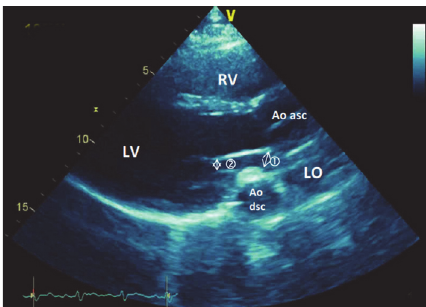
Figure 2: Echocardiography at maximal exercise. RV, right ven- tricle; LV, left ventricle; LO, left atrium; Ao dsc, descending aorta; Ao asc, ascending aorta; A , compression of the mitral annulus; B , compression of the mitral